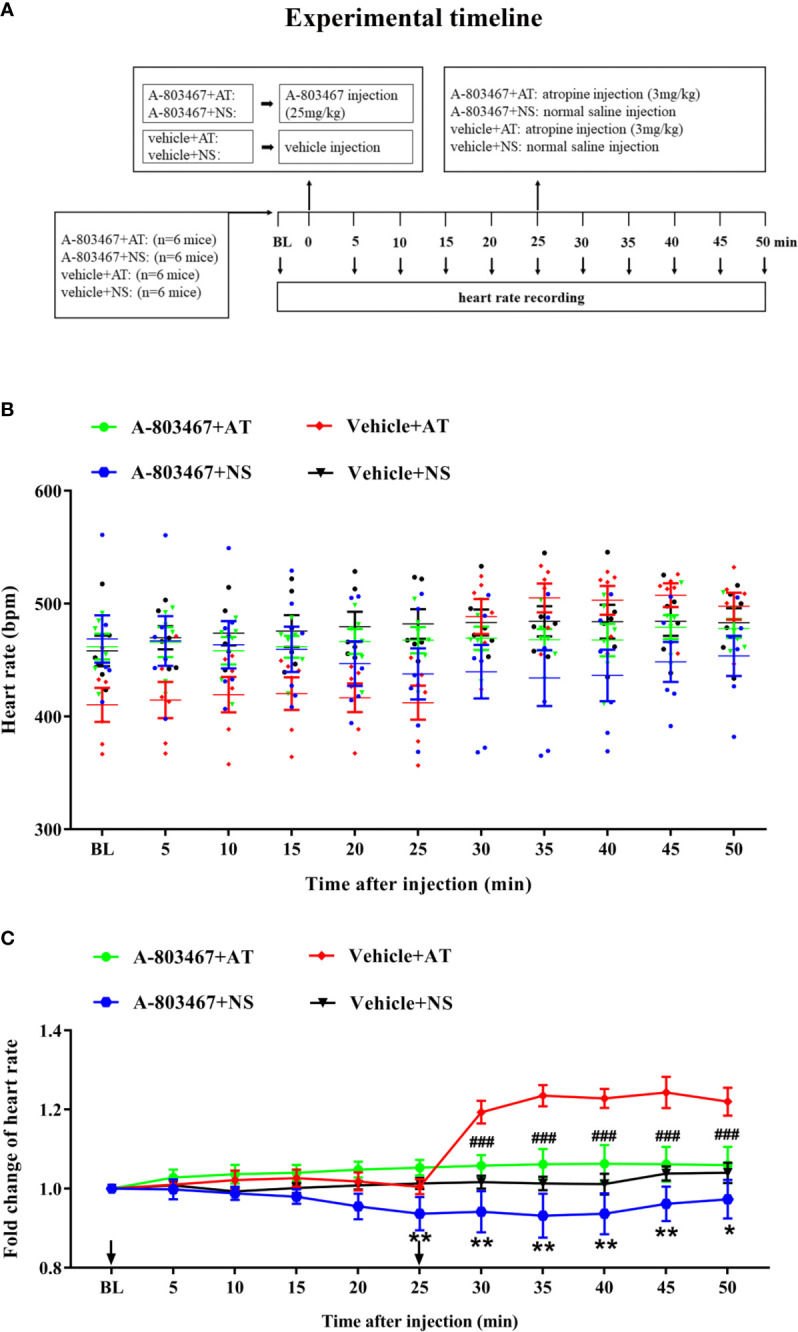
The effect of NaV1.8 inhibitor in heart rate response of atropine in wild type mice. (A) Timeline of the experiment. (B) Scatter diagram of heart rate after A-803467 and atropine treatment. (C) Line diagram of fold change of heart rate after A-803467 and atropine treatment. Heart rate was normalized to the value of baseline heart rate for each group. *means p < 0.05, **means p < 0.01 vs vehicle+NS group. ###means p < 0.001 vs vehicle + atropine group.